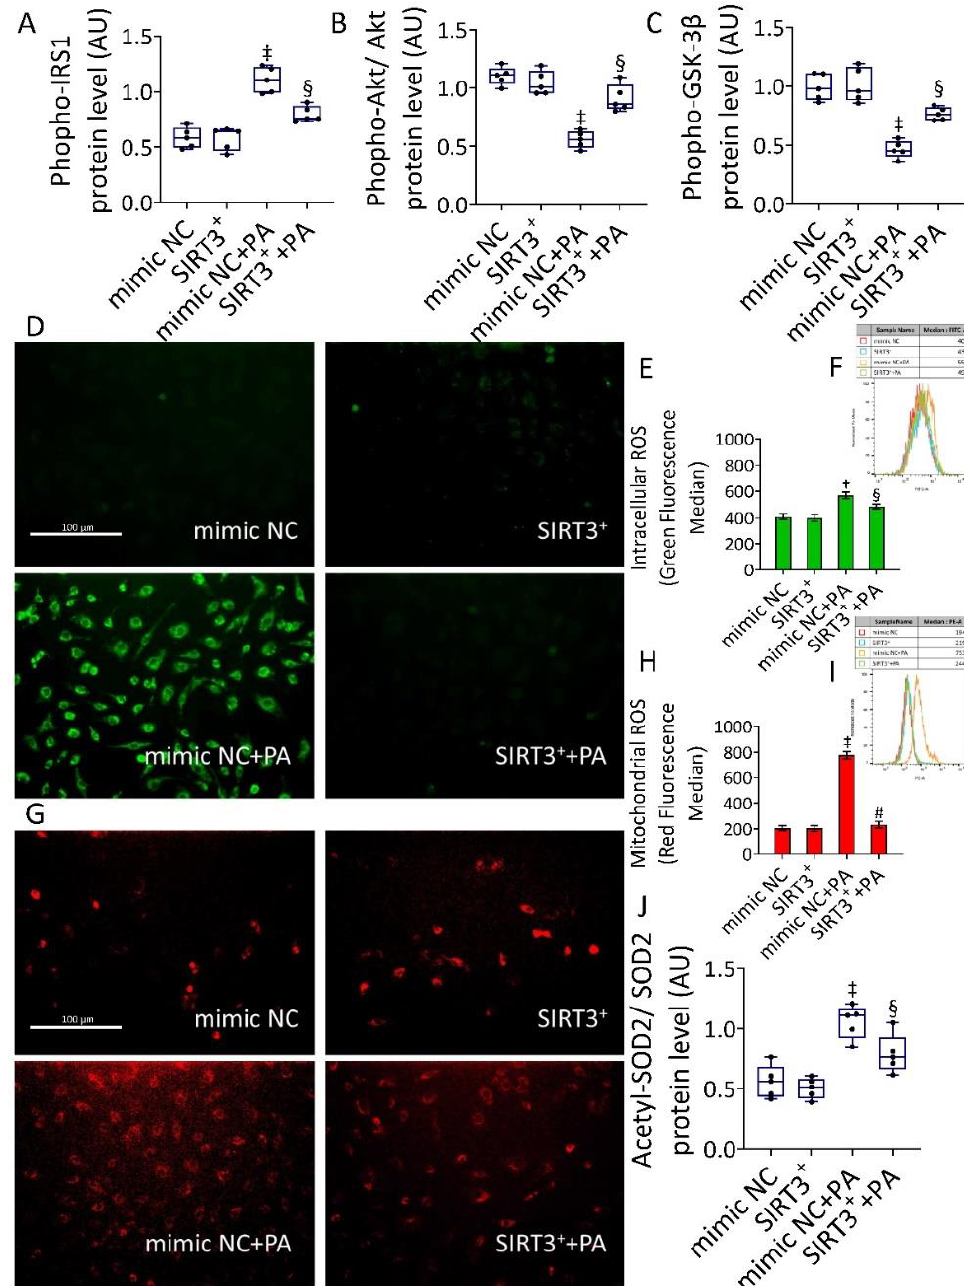
Figure 3. SIRT3 + decreased the PA-induced IR and oxidative stress. ( A ) phospho-IRS1, ( B ) phospho- Akt/Akt, and ( C ) phospho-GSK-3 β protein expression. Representative images by fluorescence microscopy and FACS analysis of ( D – F ) intracellular and ( G – I ) mitochondrial ROS detection, ex- pressed as MFI, and ( J ) acetylated-SOD2/SOD2 protein levels in EC transfected with mimic Negative Control (mimic NC), SIRT3 mimic (SIRT3 + ), mimic Negative Control and then exposed to 0.5 mM PA for 48 h (mimic NC+PA) or SIRT3 mimic before 48 h treatment with PA (SIRT3 + +PA). Scale bars = 100 µm. Western blotting results ( n = 5) are expressed as arbitrary units (AU) and represented as boxplots. † p < 0.01 vs. mimic NC; ‡ p < 0.001 vs. mimic NC; § p < 0.05 vs. mimic NC+PA; # p < 0.01 vs. mimic NC+PA.